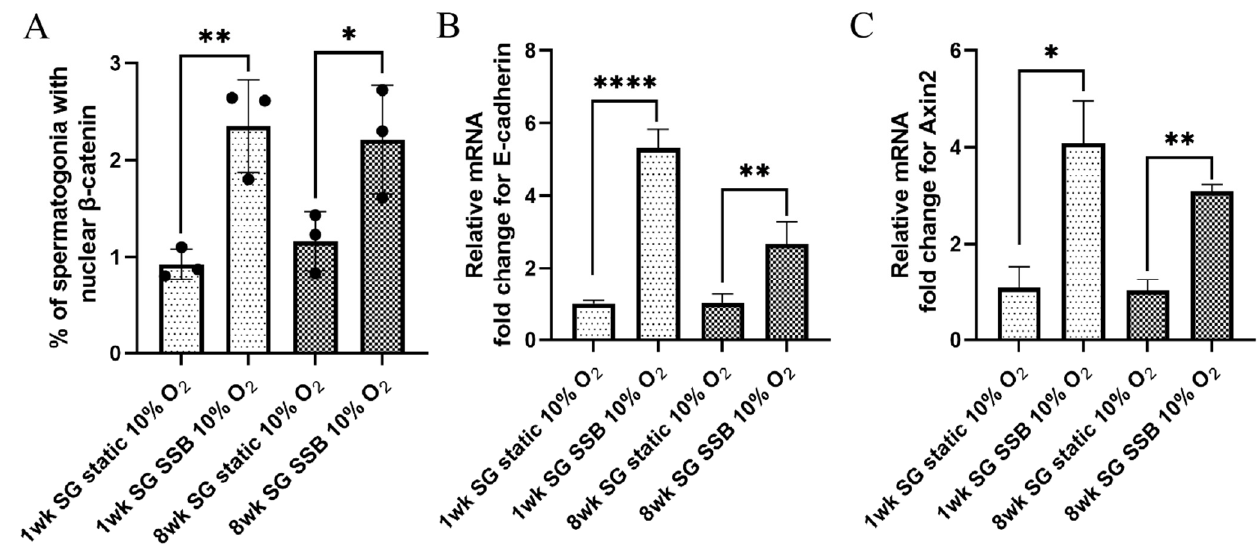
Figure 3. Suspension bioreactor culture elicits Wnt/ β -catenin pathway activation: ( A ) percentage of 1- and 8-week-old spermatogonia (SG) with nuclear β -catenin; ( B ) relative mRNA fold change of E-cadherin for 1- and 8-week-old spermatogonia (SG); ( C ) relative mRNA fold change of Axin2 for 1- and 8-week-old spermatogonia (SG). n = 3, mean ± SD. p > 0.05 (ns), p ≤ 0.05 (*), ** p ≤ 0.01, **** p ≤ 0.0001.